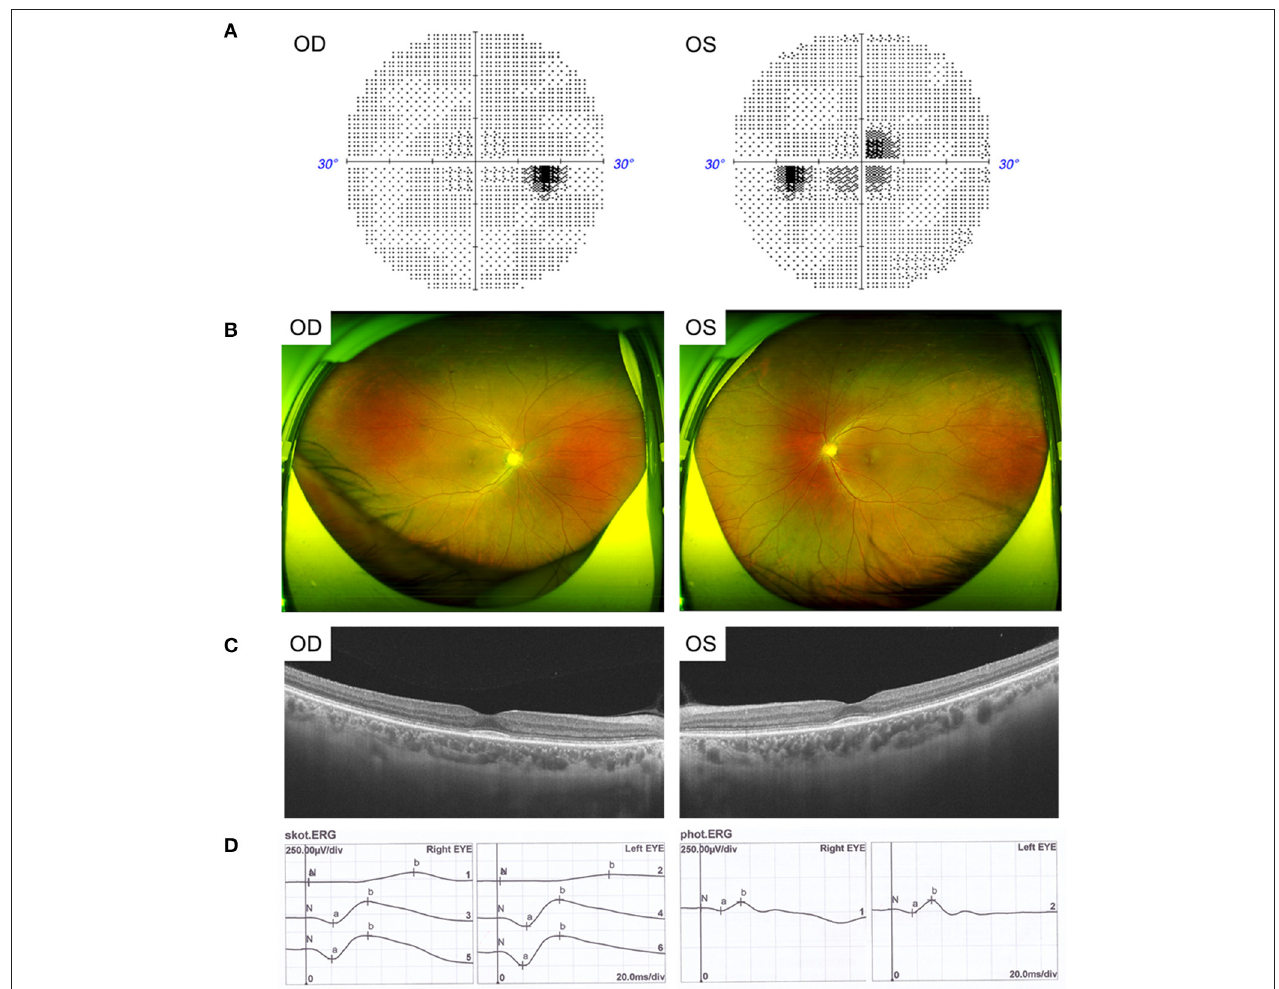
FIGURE 2 | Clinical features of the father with CRD. (A) Visual field showed central scotoma. (B) Fundus photographs showed circular degeneration around macular fovea. (C) SS-OCT revealed the binocular macular area outer retinal was thinned by atrophy. (D) ERG showed a moderate decrease in the binocular cone and rod